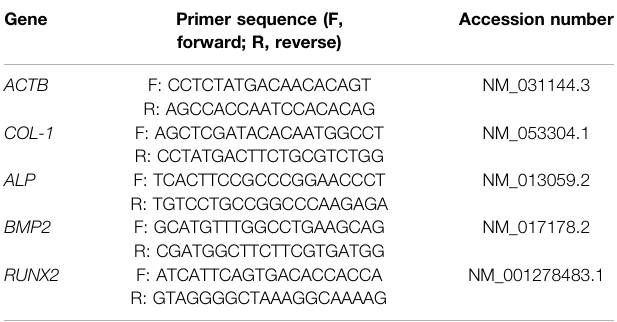
TABLE 1 | Primer sequences used for qPCR measurements. Primer sequence (F, forward; R,